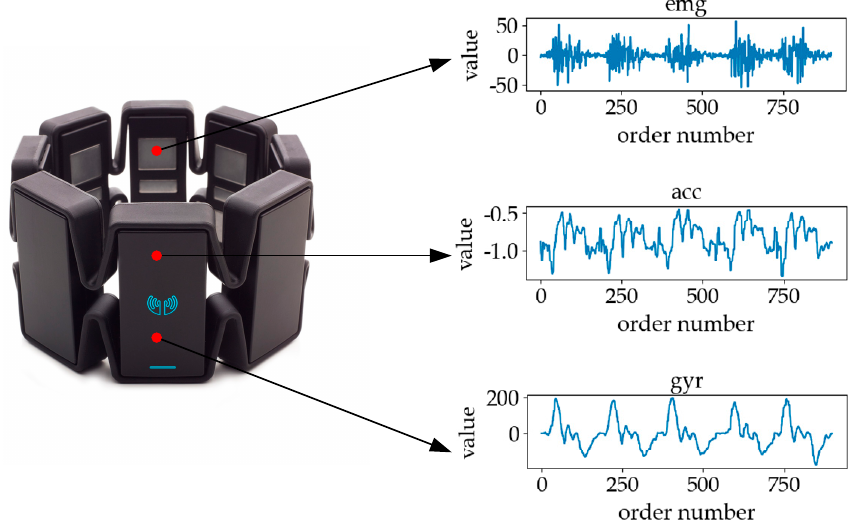
Figure 4. The wearable device we used to collect the sign language signals data including sEMG, accelerometer (ACC), and gyroscope (GYR).